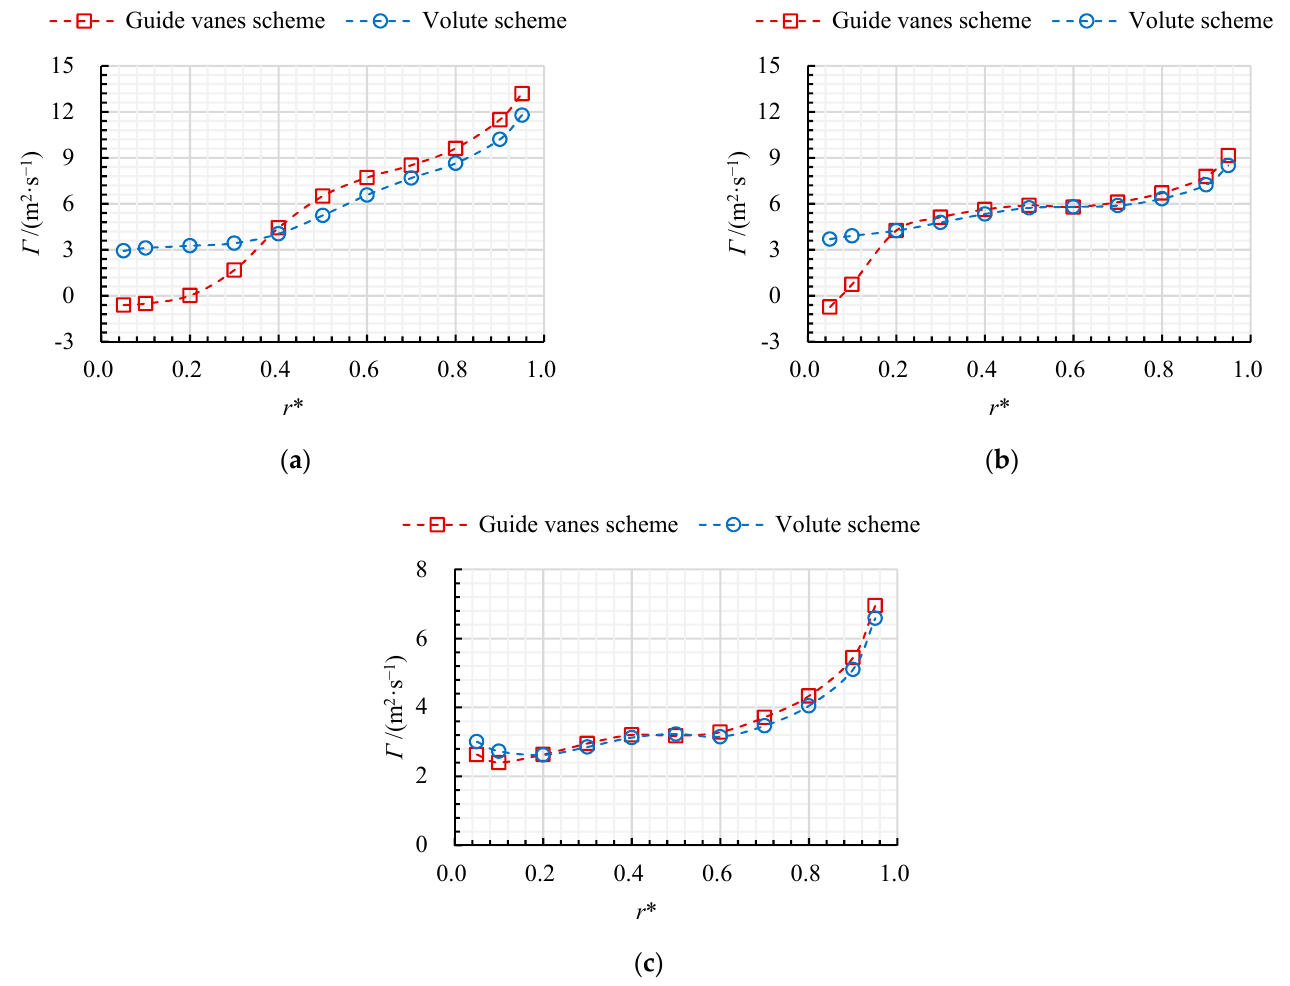
Figure 10. The average radial distribution of Γ at impeller outlet under ( a ) Q = 800 m 3 /h, ( b ) Q = 1200 m 3 /h, and ( c ) Q = 1600 m 3 /h.